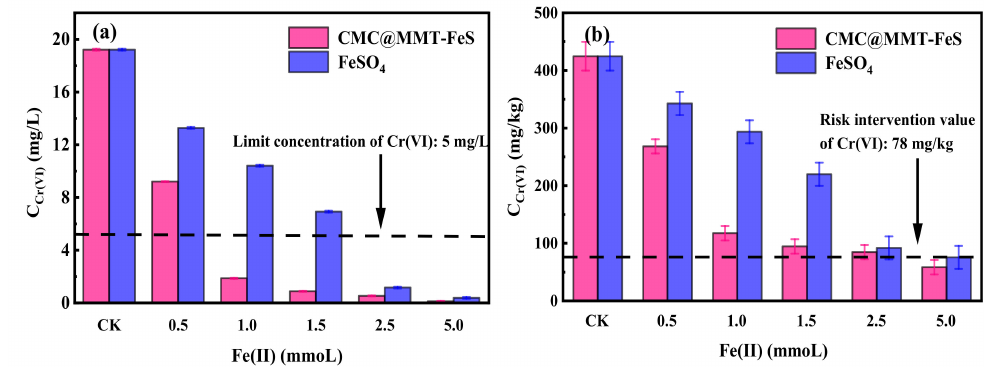
Figure 4. Concentration of Cr(VI) ( a ) in leaching by toxicity characteristic leaching procedure (TCLP) tests, and ( b ) in soil samples before and after soil remediation using 0.5 CMC@MMT-FeS (i.e., composite containing FeS at 0.5 mmol / g) and the FeSO 4 reagent. CK: control